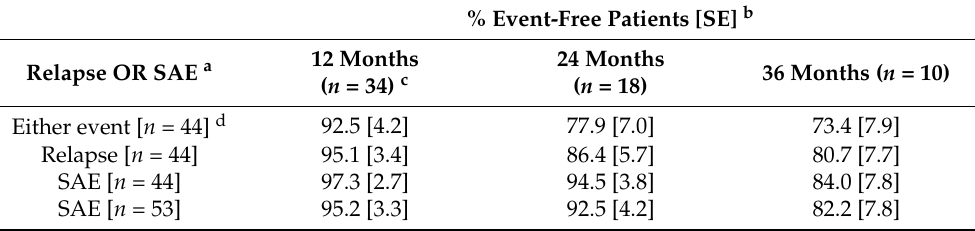
Figure 4. “Feasibility-limiting-event”-free survival as a function of the follow up period in months (Kaplan–Meier method). The short perpendicular bars represent censoring events. ( A ) Relapses, i.e., disease reactivations six months or longer after treatment, started in a patient who had previously achieved disease remission for at least four weeks. ( B ) Severe adverse events. Inserts: Corresponding comparisons of patients still on low-dose methylprednisolone (4 or 8 mg/day) at week 12 after the start of treatment (grey) vs. already off MP at that time (black). p -values: significance levels of corresponding Log-Rank tests. Table 3. Percentage (%) of event-free patients as a function of the follow-up time for relapses, severe adverse events, or either of latter events (Kaplan–Meier